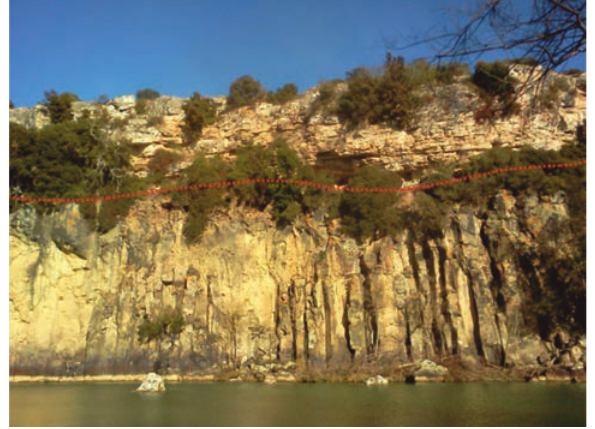
Figure 2. Tephritic lava - travertines